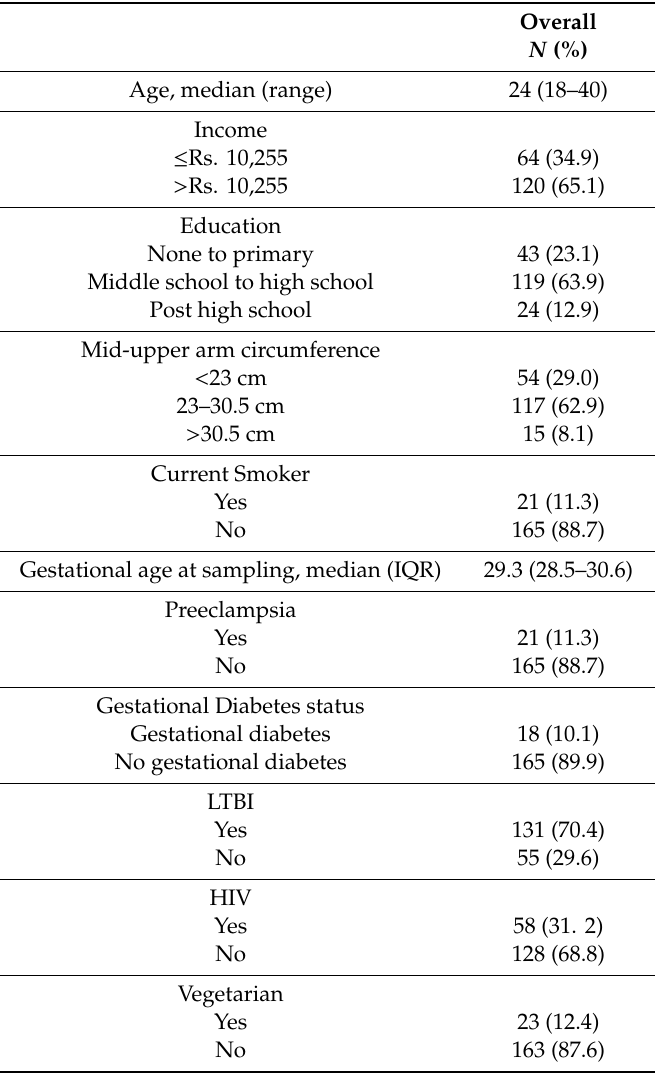
Table 1. Characteristics of the study population ( N =